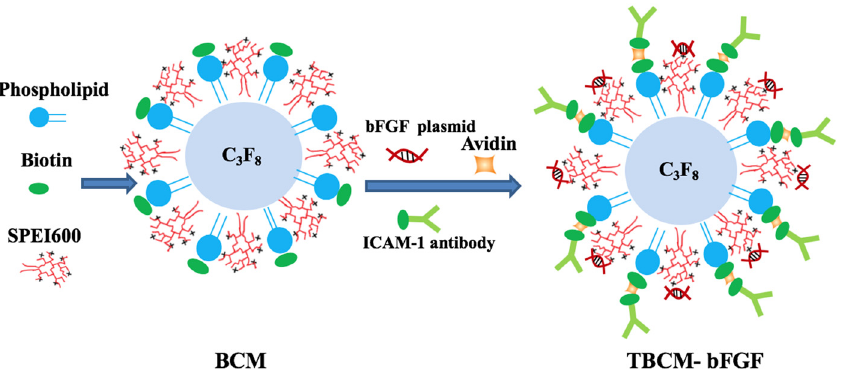
Figure 1: Schematic illustration of cationic microbubbles. SPEI600, DSPC, and DSPE – PEG 2000 – Biotin fi rst self - assembled to form BCM under a C 3 F 8 environment. Then, biotinylated ICAM - 1 assembled onto the shell of the TBCM by avidin – biotin interaction. Meanwhile, the plasmid bFGF can further assemble on the TBCM through electrostatic interaction and change to TBCM -